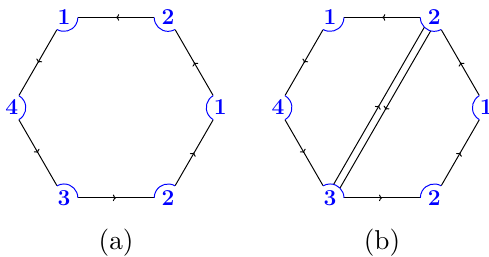
Figure 7 . All bigger polygons, such as the hexagon shown in (a), can be split into squares by adding further bridges, as shown in (b). Adding such bridges does not increase the genus of the surrounding